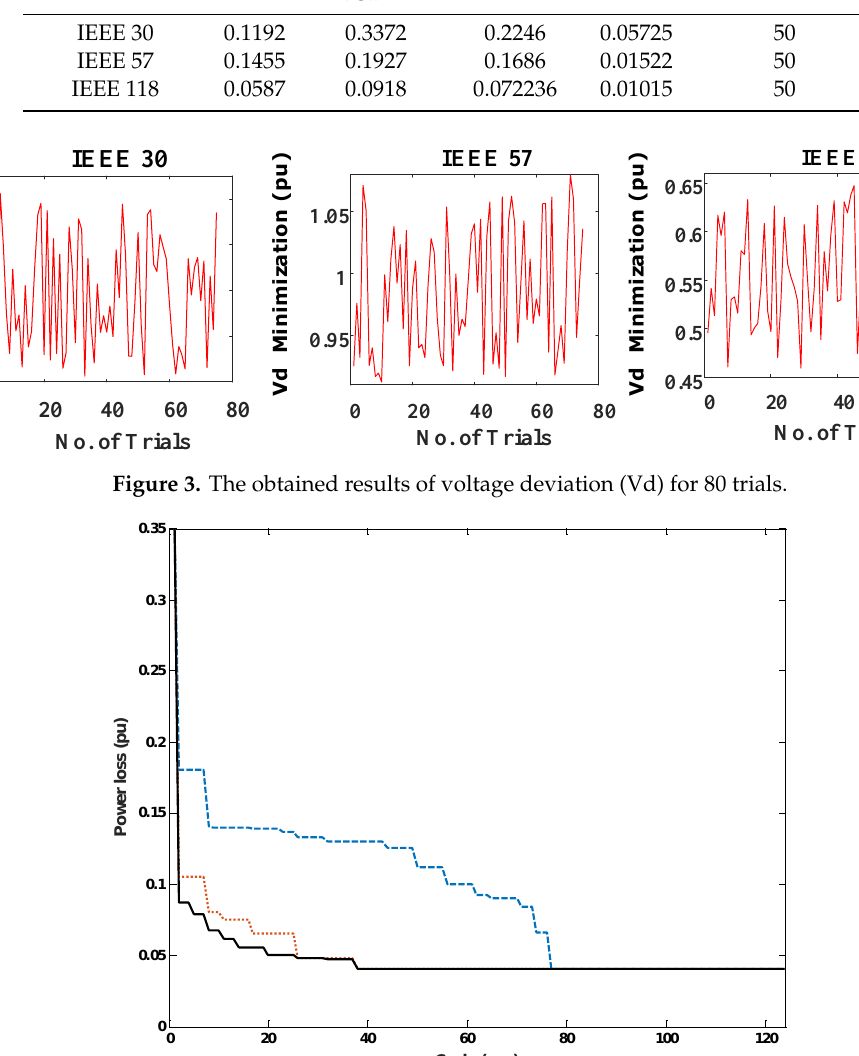
Figure 5. The Weibull distribution of the obtained voltage stability improvement (VSI) values around the mean in 50 trials.